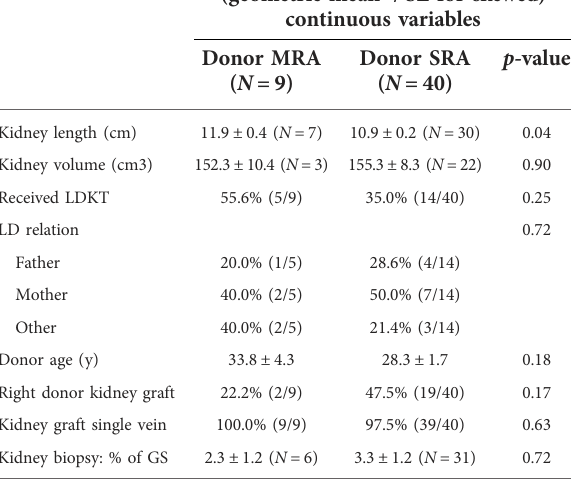
TABLE 2 Associations of baseline donor variables with donor multiple renal artery status. Baseline variable